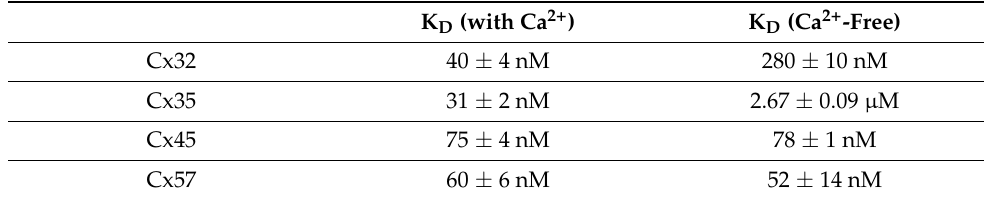
Table 2. CaM binding to